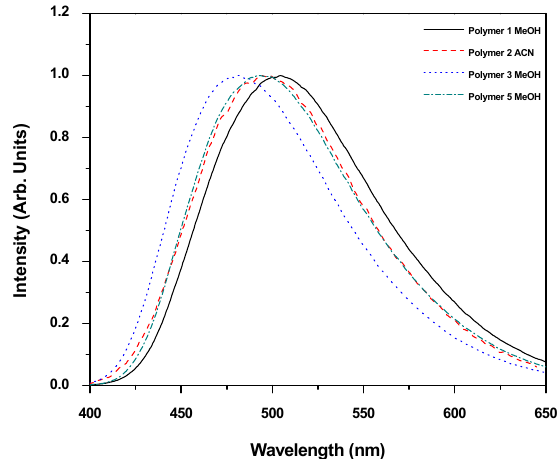
Figure 8. Emission spectra of polymers 1 , 2 , 3 , and 5 in thin films cast from methanol or acetonitrile at various excitation wavelengths.